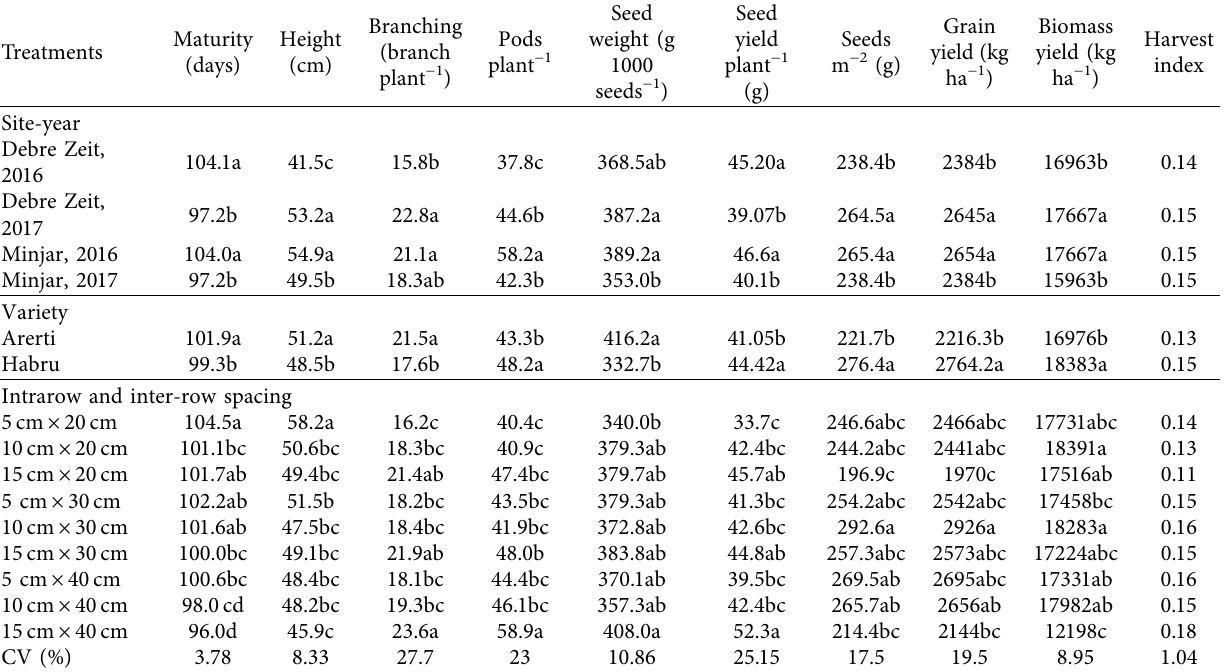
Table 4: Phonology, growth parameters, yield and yield components of chickpea as influenced by site year, variety, and inter-row and intrarow